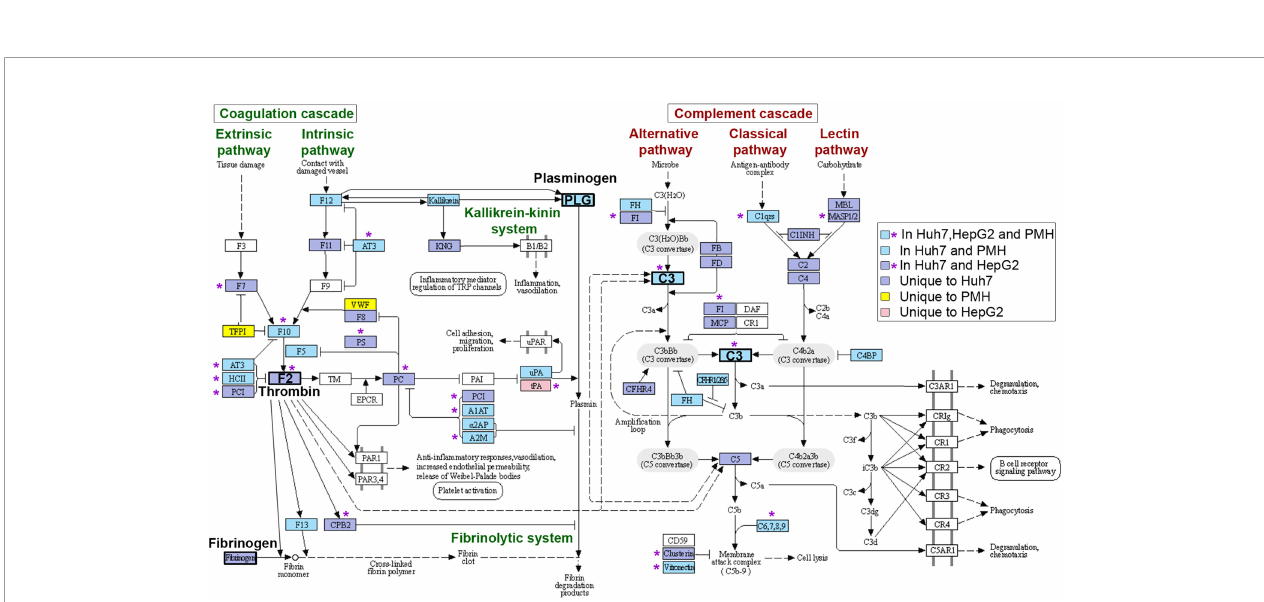
FIGURE 5 | Mapping of APP genes downregulated upon long-term Listeria infection on the “ complement and coagulation cascade ” KEGG pathway. Colored boxes and purple stars indicate components of the cascades speci fi cally altered in three, two or one hepatocyte model (as shown by the legend on the right). The hsa04610 KEGG pathway was adapted to underline different pathways of the coagulation cascade and fi brinolytic system (left) or complement cascade (right). Key components are highlighted in bold: Thrombin ( F2 ), Fibrinogen ( FGA, FGB, FGG ), Plasminogen ( PLG ) and complement C3 ( C3 ).